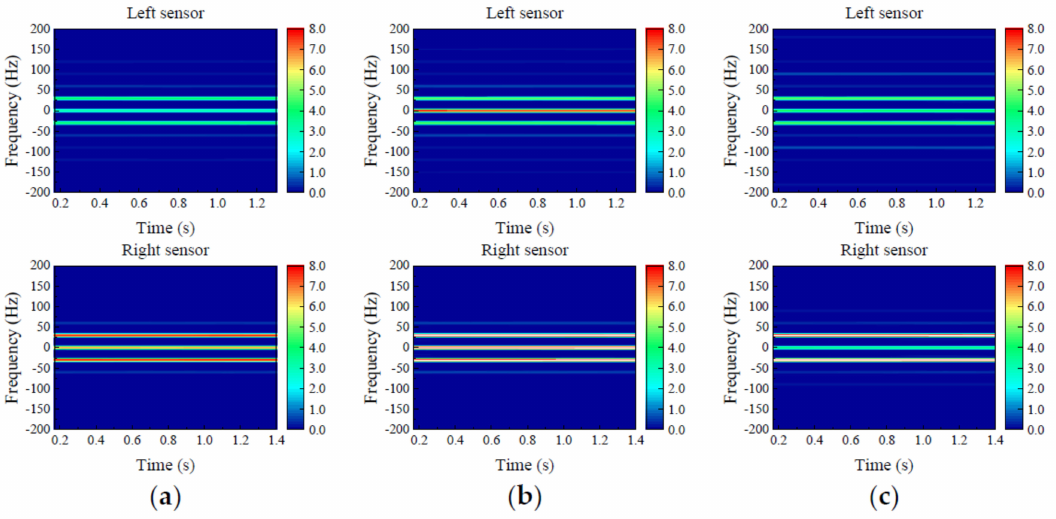
Figure 23. Time-frequency diagram of rubbing faults: ( a ) value of imbalance 2.5 × 10 − 5 kg · m;